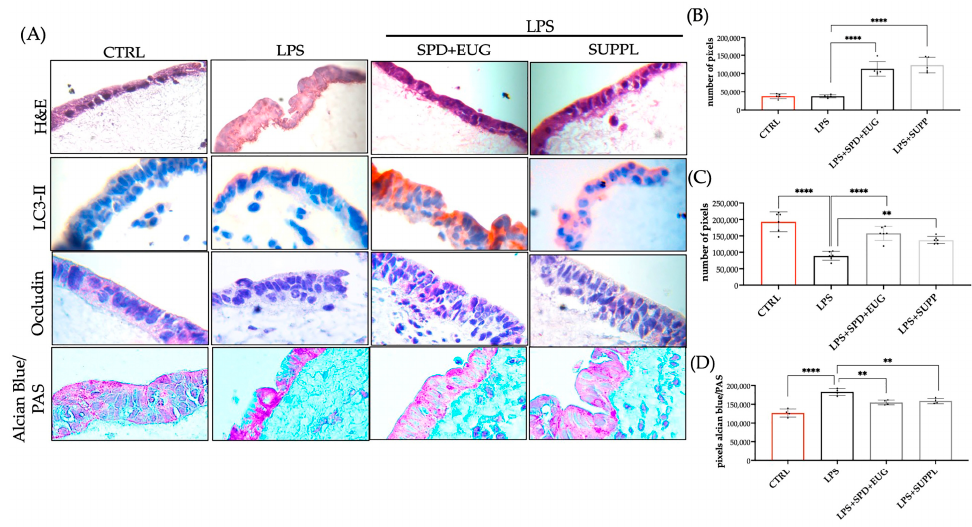
Figure 7. ( A ) Hematoxylin and eosin (H&E) staining, and LC3-II, occludin, and mucus expression of 3D intestinal equivalents (Caco-2/U937/L929 co-cultures) exposed to a 24 h pretreatment of either 1.2 spermidine (SPD) and 0.2 mM eugenol (EUG) or supplement (1.2 µM SPD + 92 µM EUG) prior to the addition of lipopolysaccharide (LPS, 1 ng/mL) for a further 24 h compared to the untreated control (CTRL) and LPS treatments alone. The magnification was ×60. ( B ) Quantification of LC3-II-red chromogen staining, ( C ) occludin–red chromogen staining ( D ) mucus expression from Alcian Blue/Periodic Acid-Schiff Stain (PAS) staining of the Caco-2 cells. Significant differences were represented as follows: ** 0.001 < p < 0.01, **** p < 0.0001. The black dots indicate the positioning of the individual replicates within the bar for each sample.